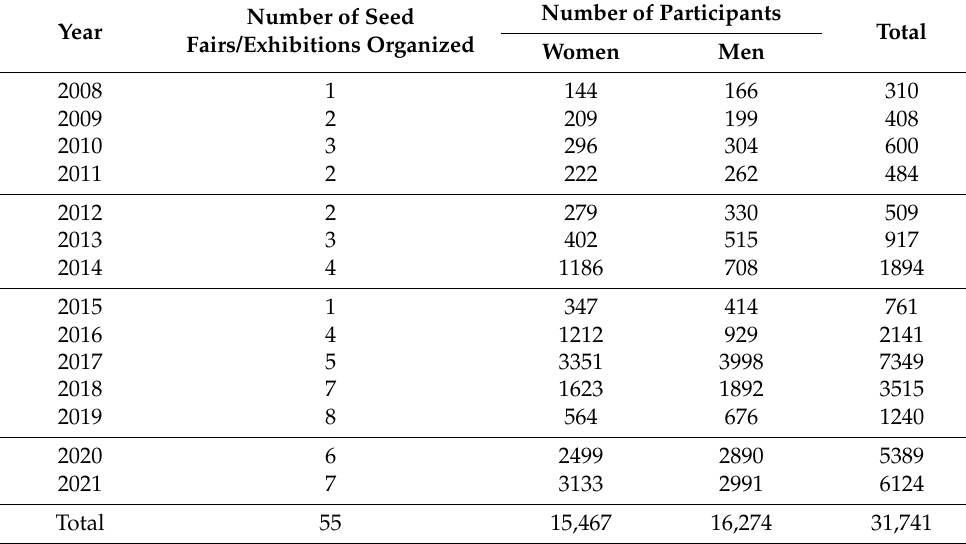
Table 6. Number of seed fairs conducted in